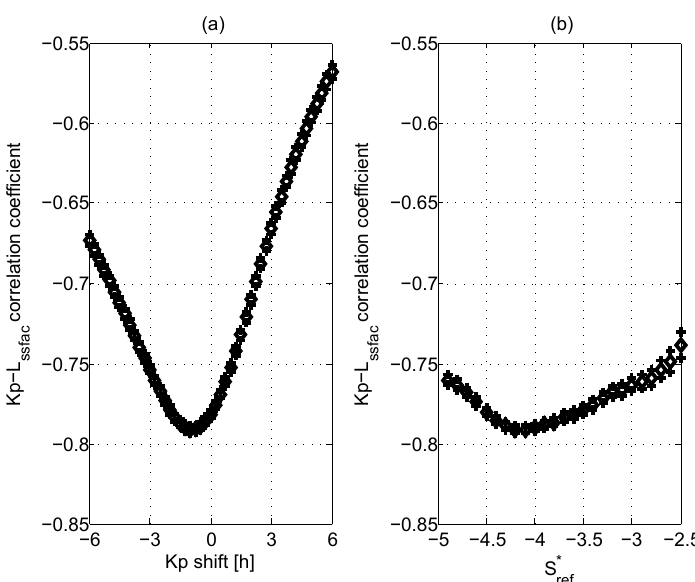
Figure 1. (a) L ssfac –Kp cross-correlation, and (b) correlation between L ssfac and Kp as a function of the reference level S ∗